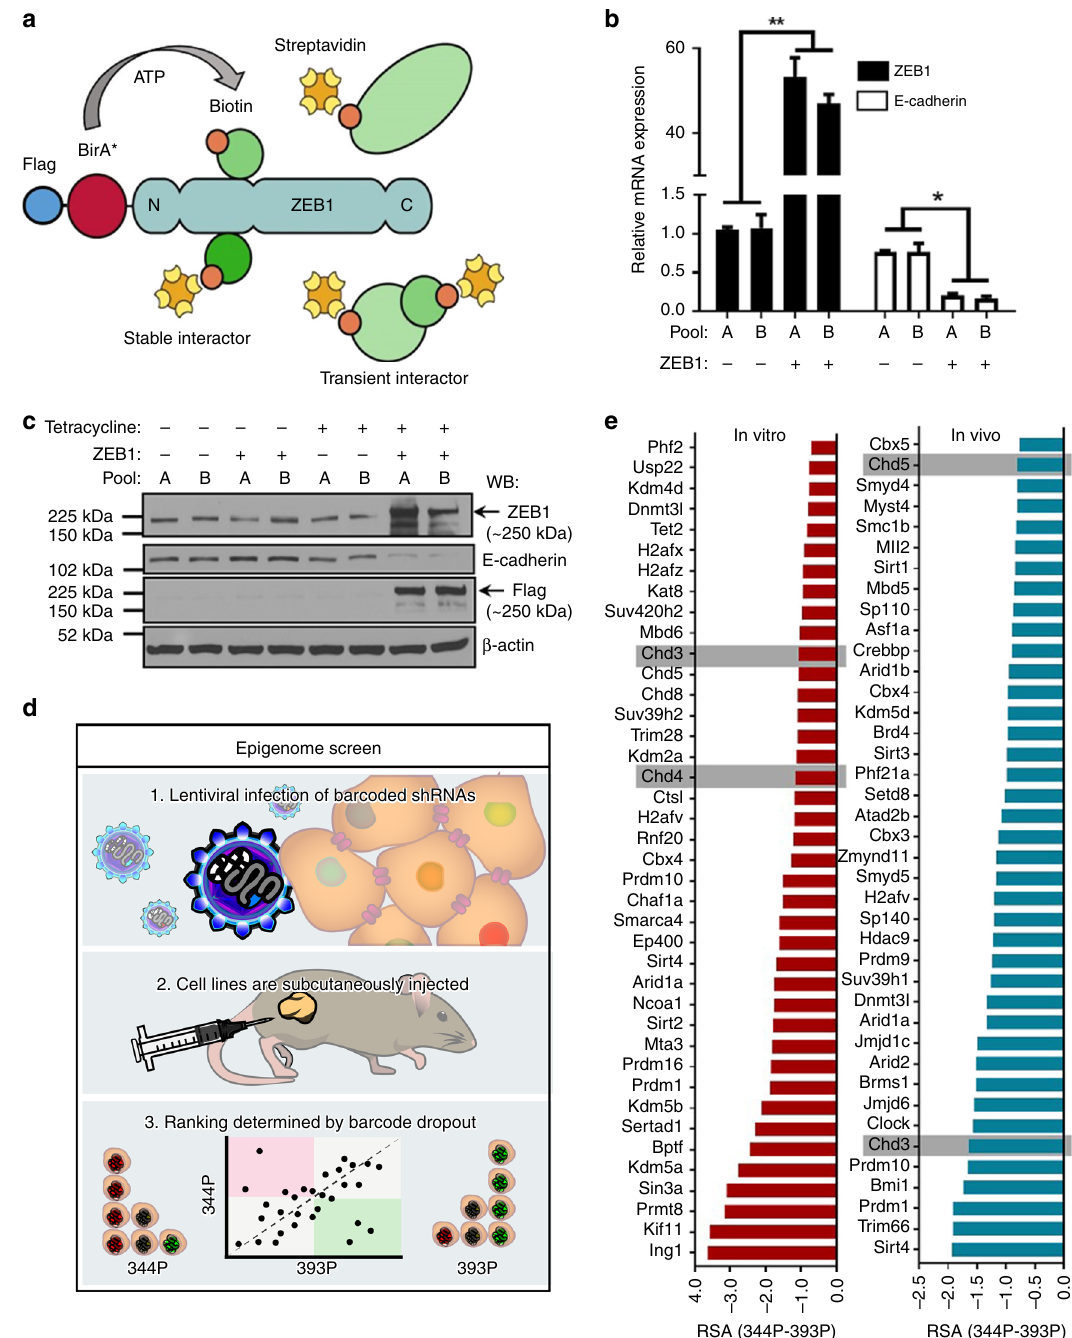
Fig. 1 Biochemical and genetic screens reveal ZEB1 interacts with NuRD complex members. a Fusion of an E . coli abortive biotin ligase mutant (BirA*) to ZEB1 allows for biotinylation of transient or stable ZEB1 interacting proteins. Biotinylated proteins are captured by streptavidin conjugated sepharose beads and identi fi ed by mass spectrometry. Human Zeb1 was cloned into the pcDNA5-FlagBirA*-FRT/TO vector and stably integrated in to HEK293 Flp-In cells. Subsequent to selection, cell lines were divided into two pools (denoted Pool A or B) and re fl ect biological replicates). Expression of the fusion protein repressed the established ZEB1 target, E-cadherin, as assessed by b qPCR and c immunoblot; all asterisks indicate statistical signi fi cance by t -test ( n ≥ 3, * p ≤ 0.05); error bars represent standard error mean. d Depiction of the Epigenome short hairpin RNA (shRNA) dropout screen. Brie fl y, (1) an shRNA library consisting of 235 unique mouse or human epigenetic regulators was infected in to the murine Kras/p53 lung cancer cell lines, 393P and 344P. (2) Syngeneic 129/Sv mice were implanted with 400 cells/shRNA and monitored for four weeks; (3) Tumors (denoted In Vivo) and cell lines (denoted In Vitro) were sequenced to determine the barcoded shRNAs abundance and e rank was determined by differential analysis of 344P and 393P RSA score. Graphs represent top fi fteenth percentile in in vitro and in vivo analyses and reveal hits with the most signi fi cant rank change between the mesenchymal 344P and the epithelial 393P